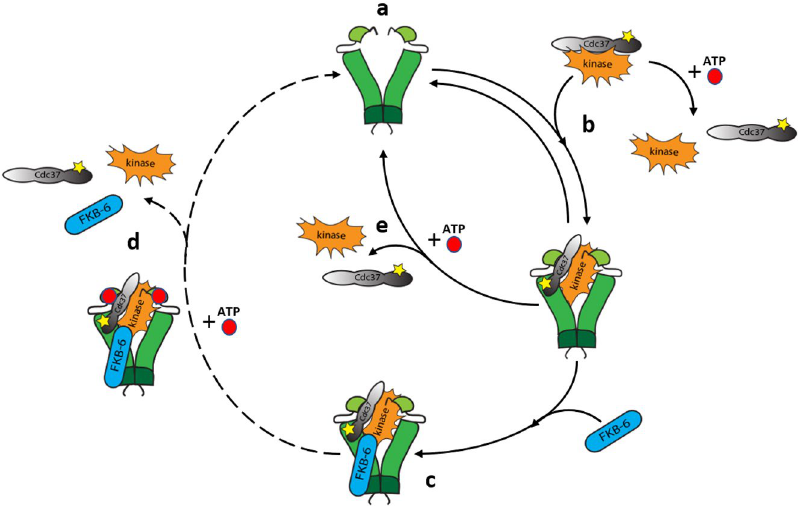
Figure 8. Graphical presentation of FKB-6 involved in the kinase cycle of HSP-90. HSP-90: Green; CDC-37: Grey; Kinase: Orange; FKB-6: Blue; ATP: Red; Dashed line: very slow event with potentially further steps, including phosphorylation of one or more of the